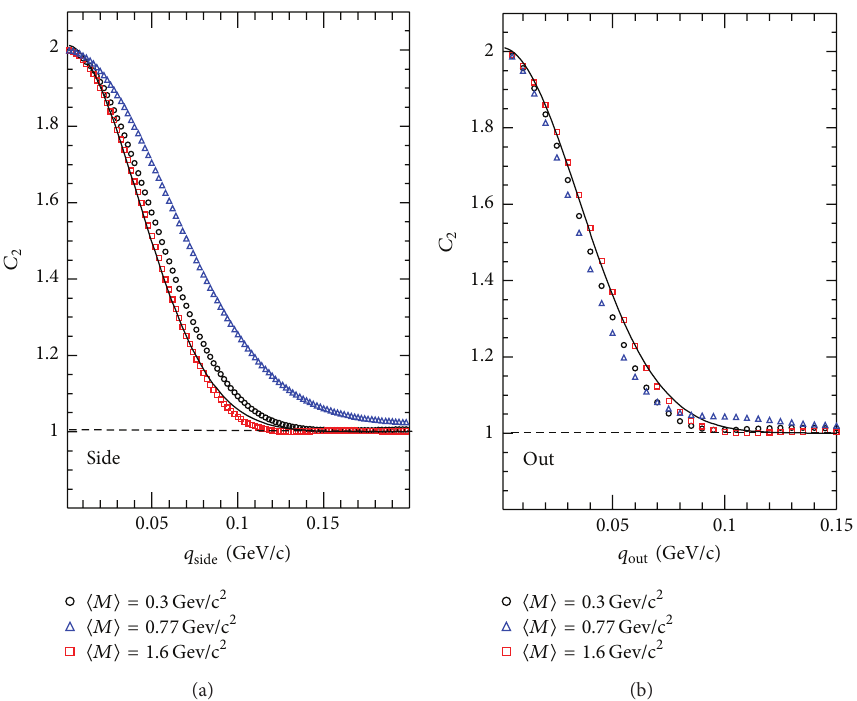
Figure 30: Correlation function for dilepton pairs as a function of 𝑞 and 𝑝 1𝑇 = 2 GeV) for three values of ⟨𝑀⟩ [14, 15]. The solid lines show the parameterization of 𝐶 2 using (77).